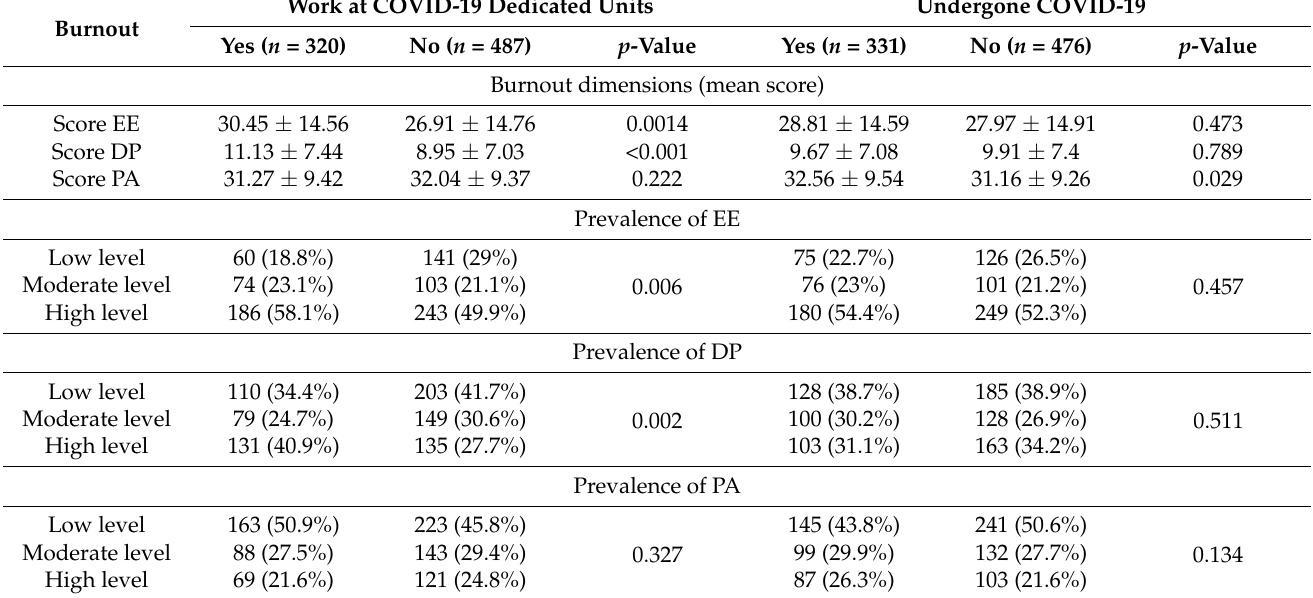
Table 5. Burnout dimensions with respect to work at units dedicated to COVID-19 patients and undergone